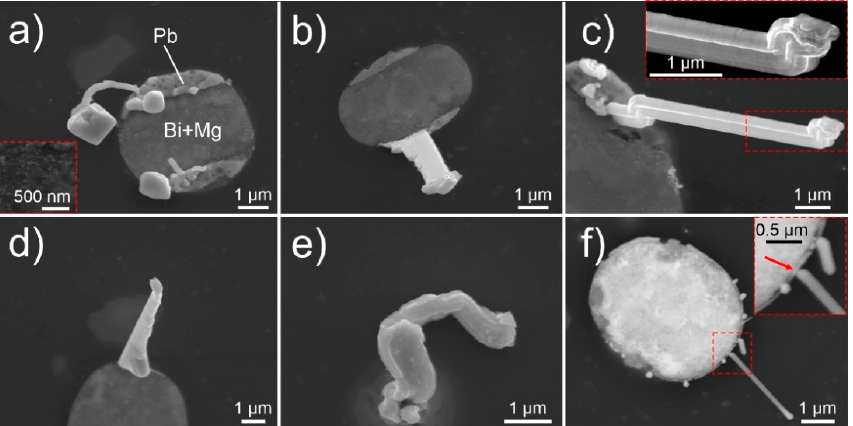
Figure 2. ( a – f ) Micrographs of various Pb whiskers and hillocks obtained with scanning electron microscopy. Images ( a – e ) are obtained with secondary electron imaging, image ( f ) is obtained with backscattering electron imaging. The inserts in figures ( c , f ) display the enlarged areas marked by dashed red box. The red arrow in insert of figure ( f ) indicates the narrow region of Pb zone of the Bi-Mg-Pb pool.